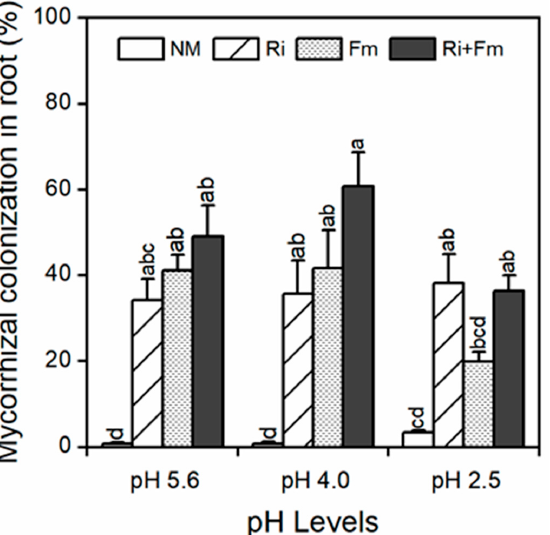
Figure 1. Effects of arbuscular mycorrhizal fungi (AMF) on mycorrhizal colonization of Torreya grandis under acid rain with pH 5.6, 4.0, and 2.5. NM, Ri, Fm, and Ri+Fm represent the four AMF treatments: inoculation with no mycorrhizal fungi, with Rhizophagus irregularis, with Funneliformis mosseae , and with the combination of the two fungi inoculum, respectively. Values are presented as the mean ± SE ( n = 3). Different letters indicate a significant difference ( p < 0.05).